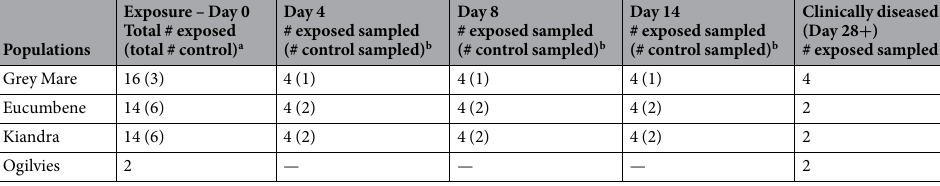
Table 1. Experimental design outlining the number of frogs from each population and treatment group (Bd exposed or unexposed control) sampled at each time point post exposure. a Total number of unexposed control frogs shown in parentheses; b Number of unexposed control frogs sampled shown in